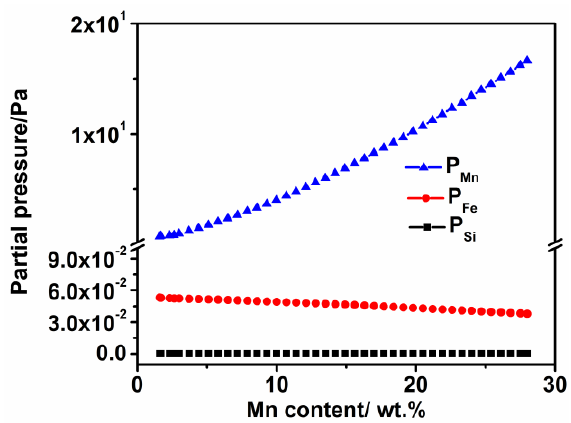
Figure 11. The partial pressure of Fe, Mn, and Si in Fe-Mn-Si sintered at 1200 °C as a function of Mn concentration.